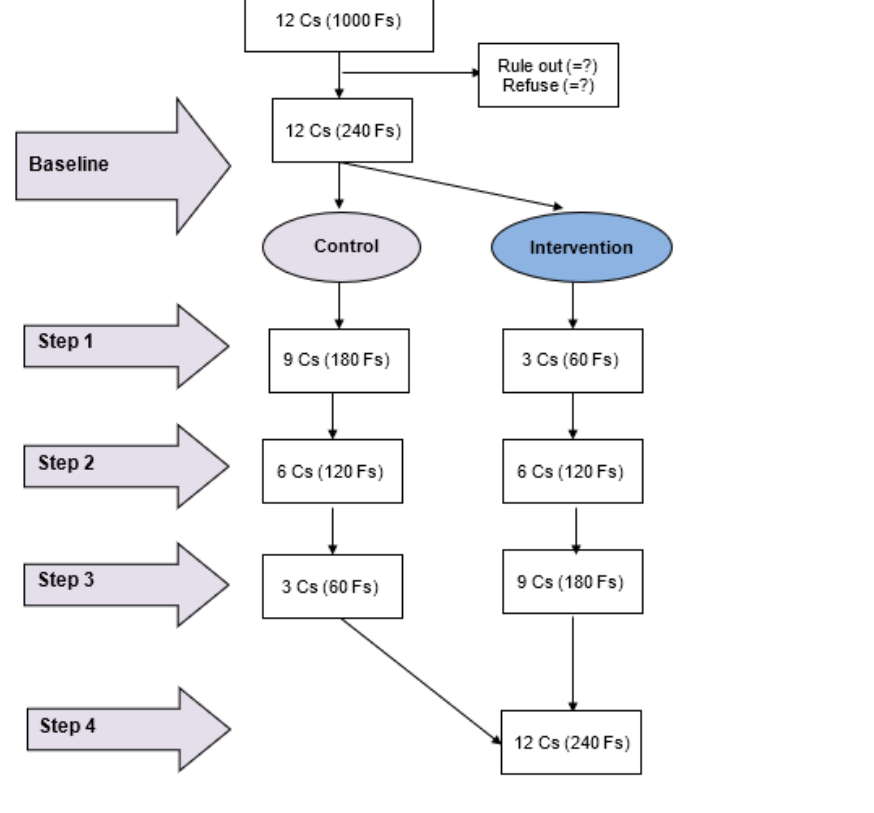
Figure 2. Flowchart for participant recruitment and allocation. C: community; F: family.